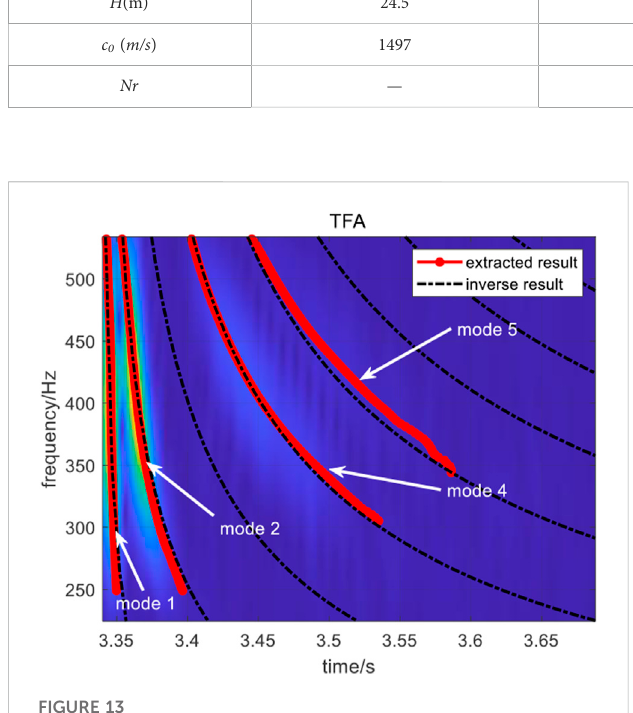
FIGURE 13 Mode determination results and dispersion curve comparison results of data